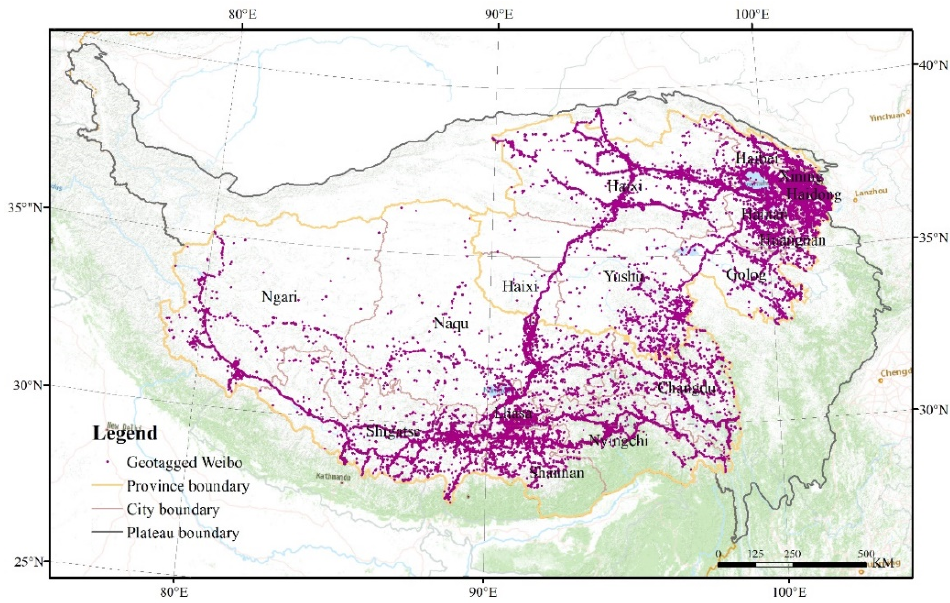
Figure 1. Study area and locations of geotagged Weibo texts.